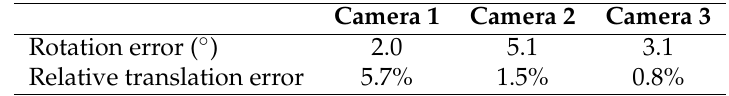
Table 4. Rotation and relative translation error of our method after refinement for each